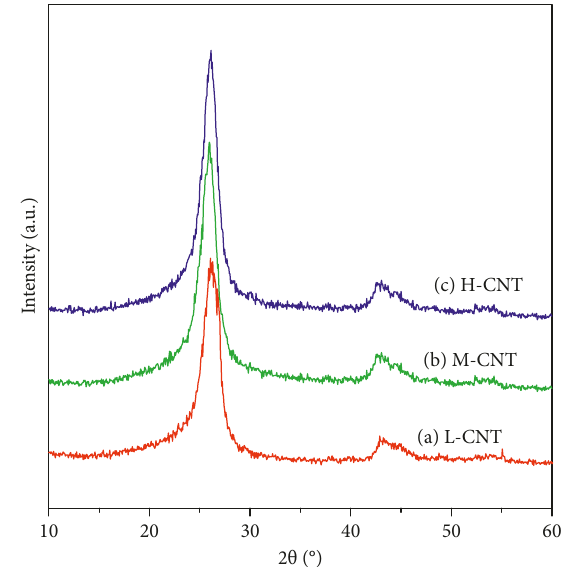
Figure 3: XRD patterns of the samples.